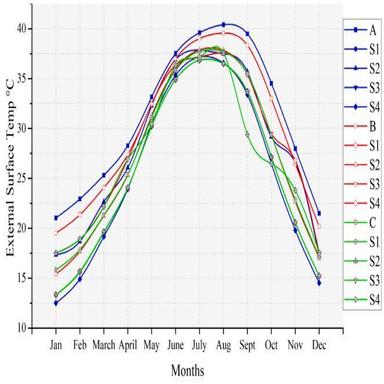
The monthly indoor temperatures and the monthly inside and external surface temperatures.